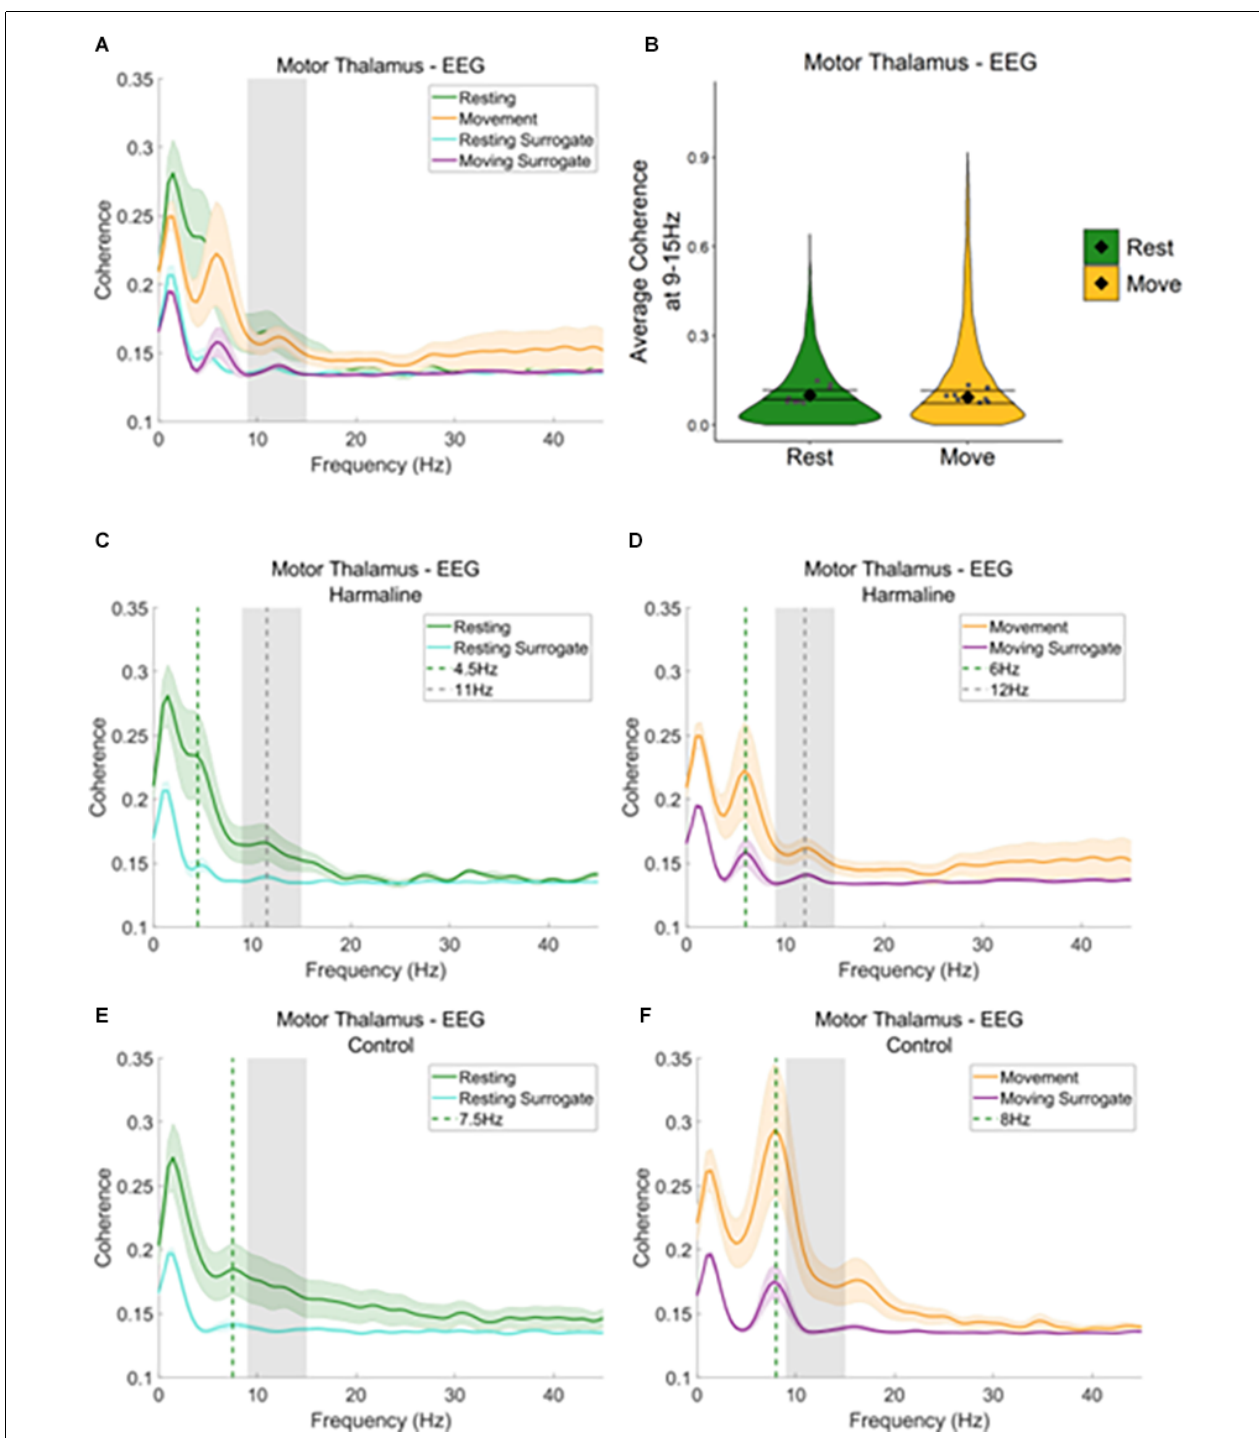
FIGURE 7 | Thalamocortical coherence in the harmaline model. (A) Mean ( ± SE) thalamocortical coherence ( n = 8) during resting and movement for real and surrogate datasets. The solid line represents mean coherence, and the coloured shaded areas represent SE. The grey area represents the tremor frequency. (B) Average surrogate-corrected thalamocortical coherence at the tremor peak across all epochs with significant coherence (pooled across rats). Individual grey points represent mean per rat. Fixed effects parameter estimates ( ± CI) representing predicted mean estimates are shown by (cid:7) and corresponding error bars. (C–F) Mean ( ± SE) thalamocortical coherence ( n = 8); coherence in harmaline model (C,D) and control (E,F) during resting (C,E) and movement (D,F) for real and surrogate datasets. The solid line represents mean coherence, and the coloured shaded areas represent SE. The grey area represents the tremor frequency.